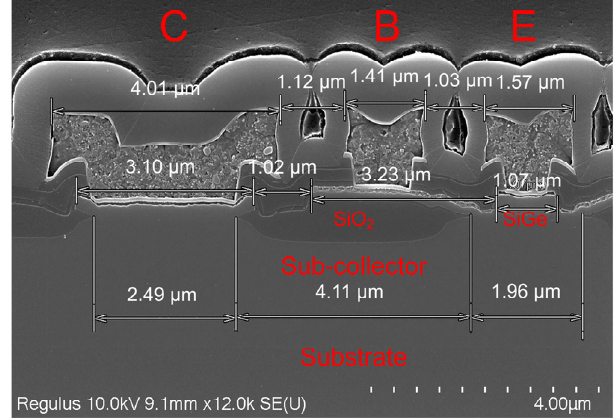
Figure 2. The SEM figure shows a cross-section of the DUT.